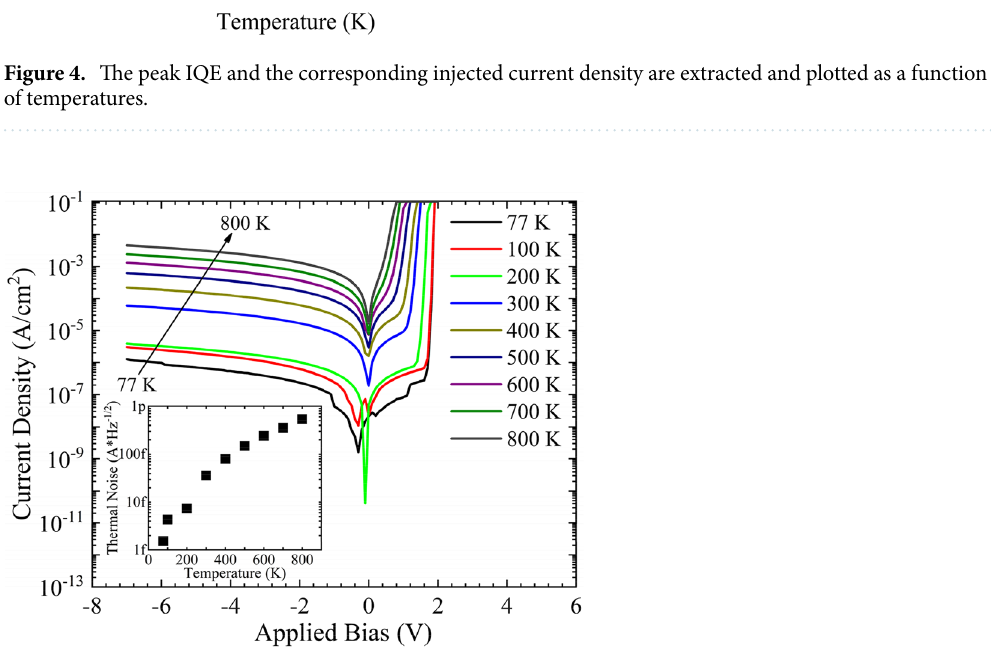
Figure 7 represnts the temperature dependant behaviour of the peak spectral responsivity of the structure at different biased conditions; inset shows the respective wavelength at which the spectral peak is observed. The structure shows a relatively small increment in the spectral peak at lower temperatures. Increasing the temperature above 300 K results in an exponential change in the responsivity. The rapid increase in the spectral responsivity above 300 K is attributed to (i) shift in the absorption spectrum towards higher wavelengths due to bandgap shrinkage, as shown in the inset of Fig. 7 (ii) reduced absorption rate at higher wavelength leads to more photons reaching the active area resulting in a higher responsivity. Biasing the structure with higher volt- ages leads to a broader space charge region resulting in enhanced spectral responsivity, as shown in Fig. 7. At elevated temperatures, the spectral peak responsivity tends to saturate at 800 K for lower bias curves. However, no sign of saturation in the spectral peak response is visible for higher biased curves, even at 800 K. The specific detectivity, D*, of the structure is extracted for different temperatures and biased conditions to quantify the performance of the photosensitivity of the structure. Figure 8 shows the peak-specific detectivity as a function of temperature for different biased conditions; the inset shows the wavelength at which peak detectivity is observed. The structure exhibits slight variation in the D* at lower temperatures. At zero bias, the D* of the structure increased from 12G Jones (cmHz 1/2 W -1 ) at 300 K to 17G Jones at 400 K. A rapid increase in the D* at 400 K is attributed to the increase in the spectral responsivity due to a significant redshift with minimal increase in the leakage current and thermal noise. The structure showed a peak D* of 22G Jones at 600 K with zero bias. The D* starts to decline at temperatures above 600 K. However, at biased conditions, the D* starts to decline at temperatures above 400 K. Although the structure shows a linear increase in spectral responsivity with bias voltage at elevated temperatures, higher noise current at biased conditions leads to a reduced D*. At elevated